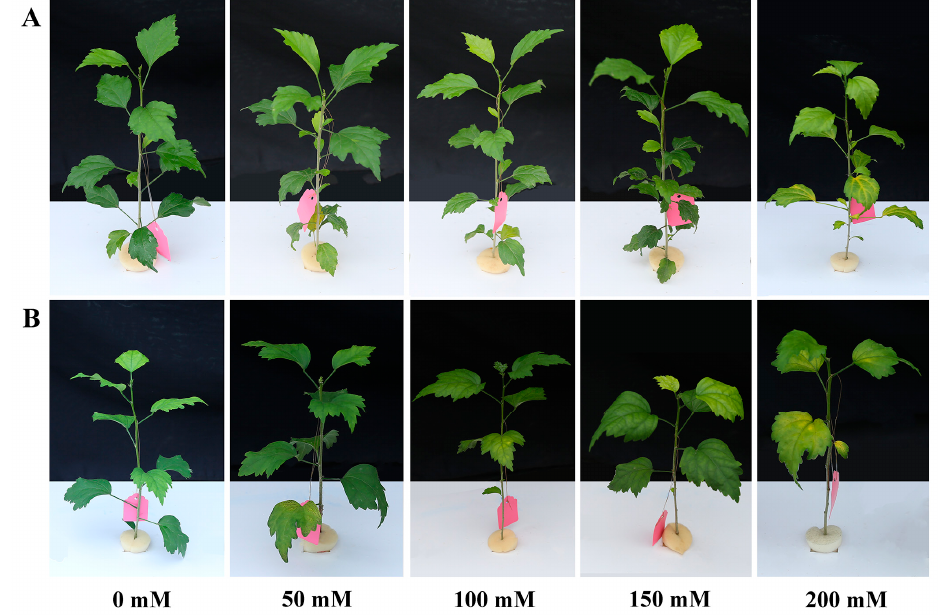
Figure 1. Effect of different NaCl concentrations on the cuttages of two hibiscus cultivars: ( A ) H. syriacus ‘Duede Brabaul’ (DB) and ( B ) H. syriacus ‘Blueberry Smoothie’ (BS).